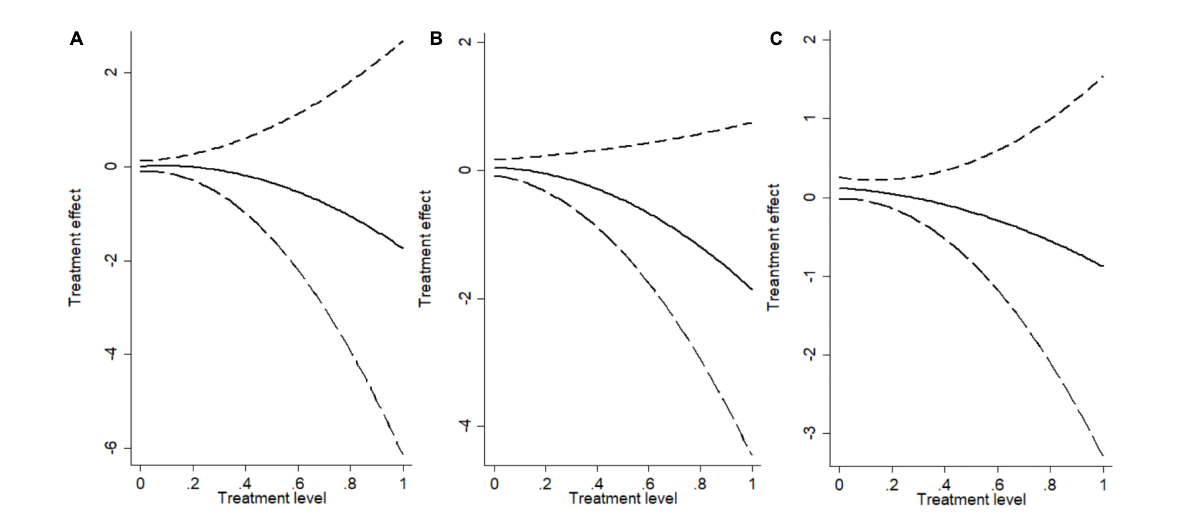
FIGURE2 Schematic diagram of the treatment effect function of all farmland (A) , paddy field (B) , and dryland (C) multiple cropping index on the relative poverty.